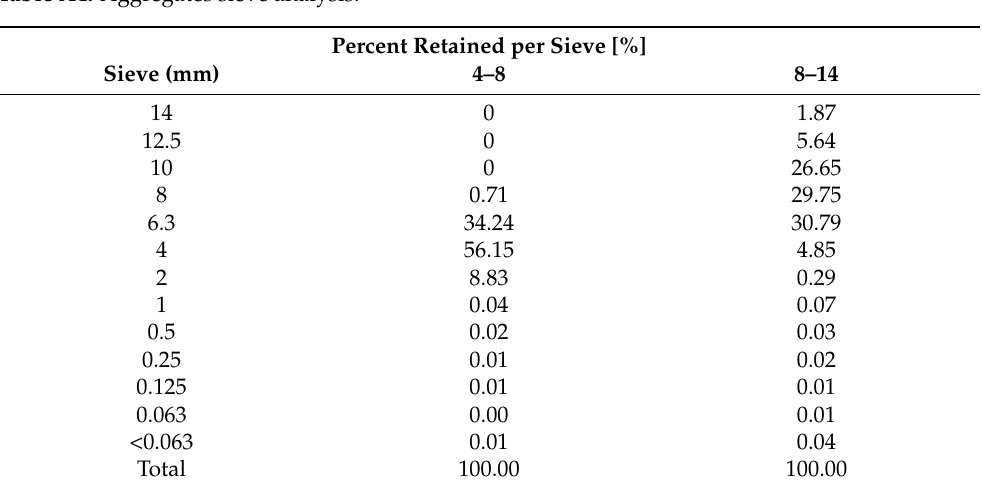
Table A4. Aggregates sieve analysis.